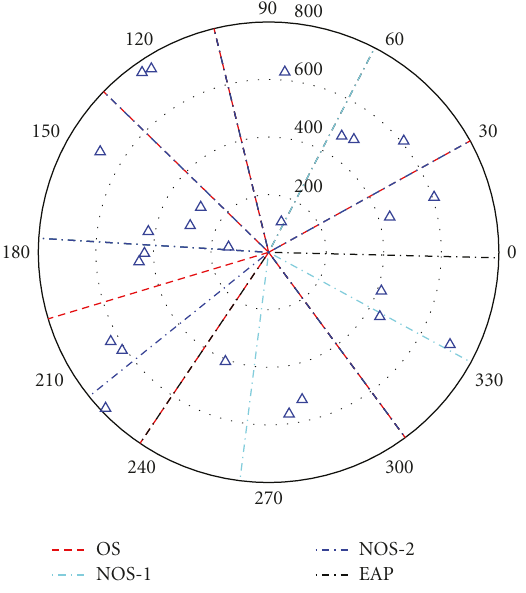
Figure 6: Sector boundaries for the uplink of a CDMA system with uniform user distribution. Number of users, M = 25; processing gain, N = 16; number of sectors, K = 6.